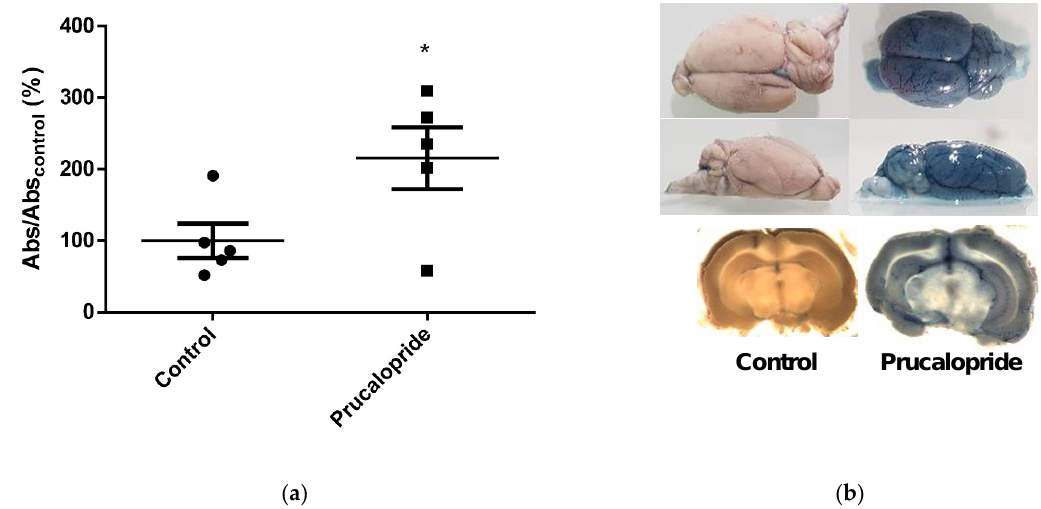
Figure 9. Evaluation of BBB diffusion of Evans blue in brains of Wistar rats. The amount of Evans blue that diffuses into the brain parenchyma increases by the 4-days-long treatment with prucalopride. ( a ) Quantification of the passage of Evans blue in the brain parenchyma by absorbance in rats treated with prucalopride (10 mg · kg −1 ) compared to the vehicle group. ( b ) Photograph of the brains of rats treated with prucalopride after Evans blue infusion compared to the vehicle group. Histograms represent mean ± SEM from 5 rats. * p < 0.05. Abs: Absorbance.